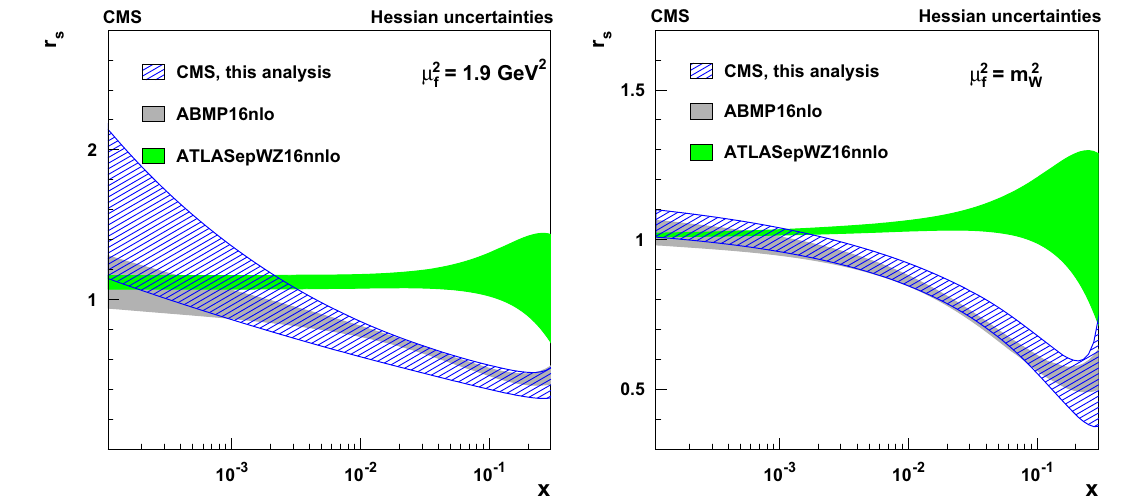
(right). The results of the current W